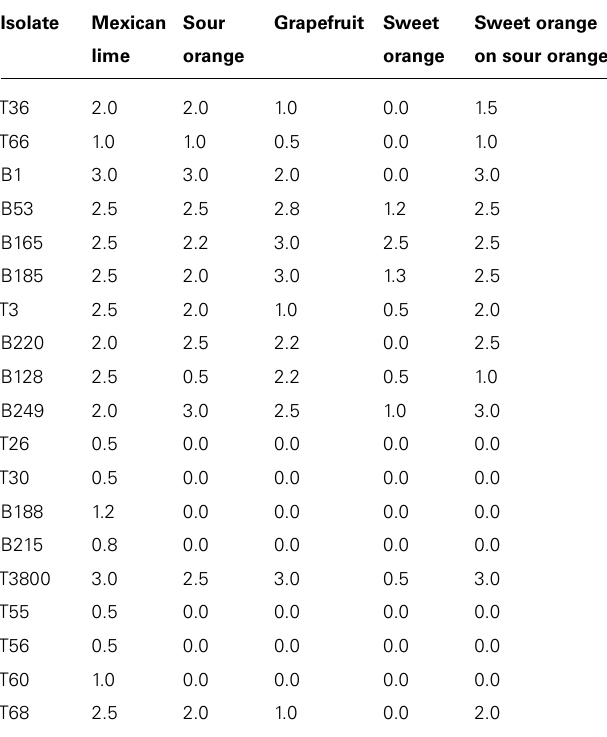
Biological activities were determined as reported by Garnsey etal. (1987, 2005) using five different indicator plants, Mexican lime, sour orange, Duncan grape- fruit, Madam vinous sweet orange, and sweet orange grafted onto sour orange rootstock. The plants are rated using a scale where 0 is healthy and 3 is most severe.The Mexican lime was rated for chlorosis, stunting, and stem pitting; sour orange for seedling yellows symptoms; Duncan grapefruit for seedling yellow, stem pitting, and stunting; Madam vinous sweet orange for chlorosis, stunting, and stem pitting, and the sweet orange on sour orange for